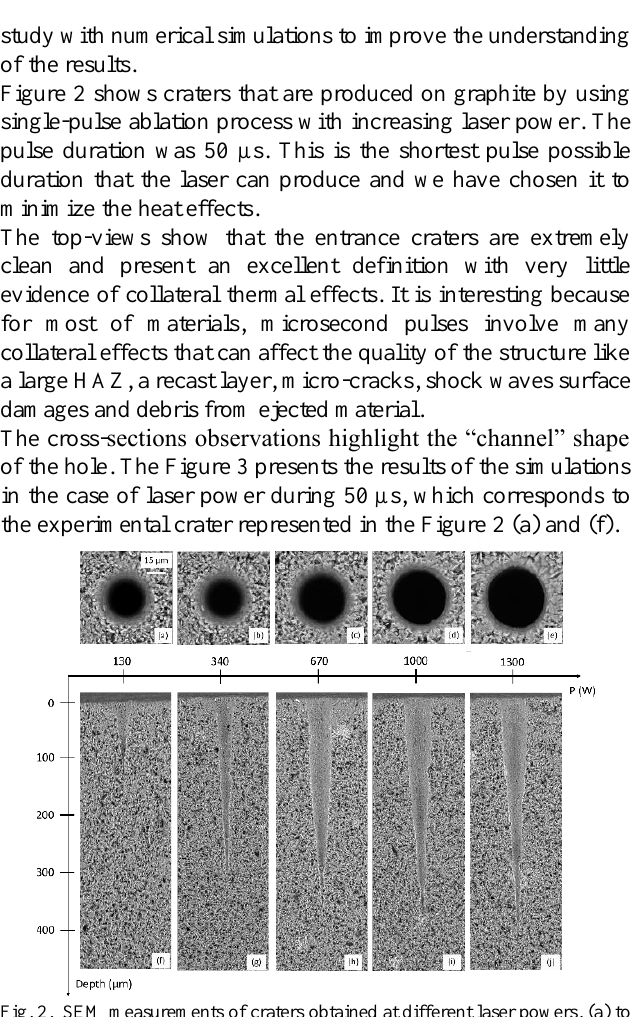
Fig. 2. SEM measurements of craters obtained at different laser powers. (a) to € and (f) to (j) are respectively top and cross-section views. The duration of the laser pulses is 50 µs.